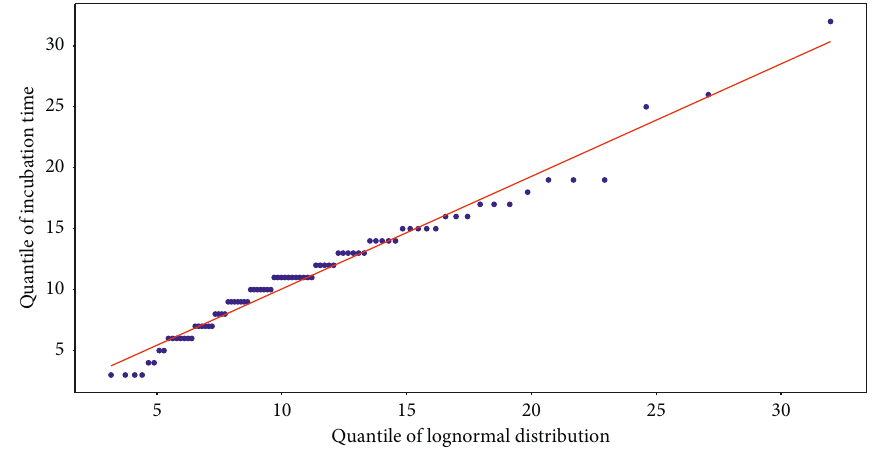
Figure 2: Q-Q chart of lognormal distribution.